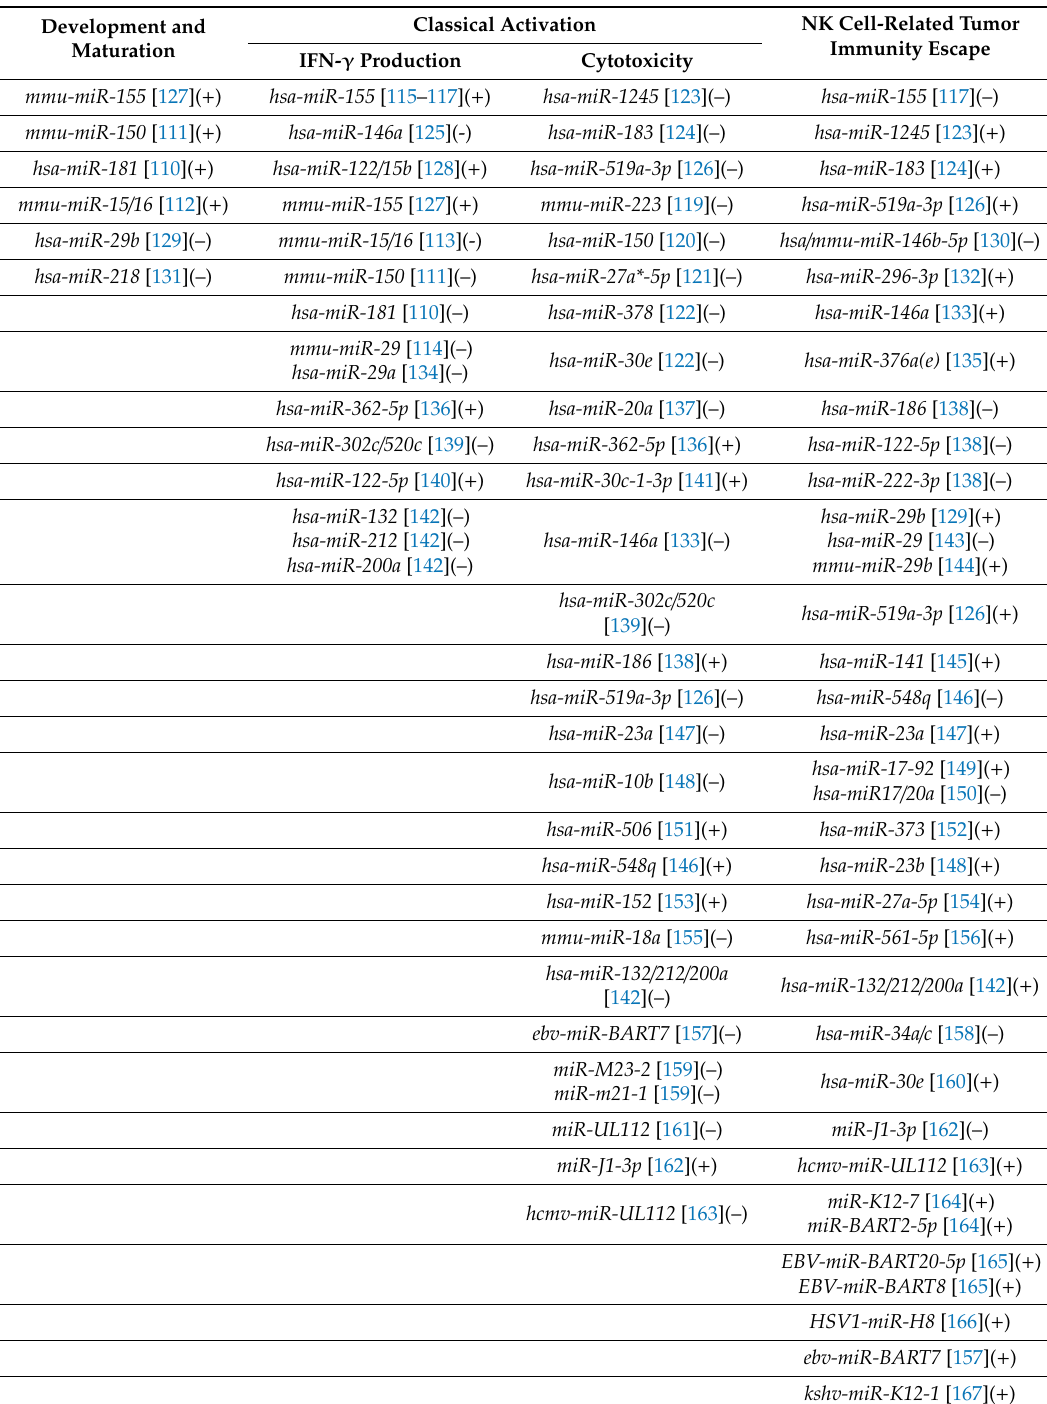
Table 2. A list of miRNAs involved in NK cell development, NK cell activation, and tumor immunity. Classical Development and Maturation